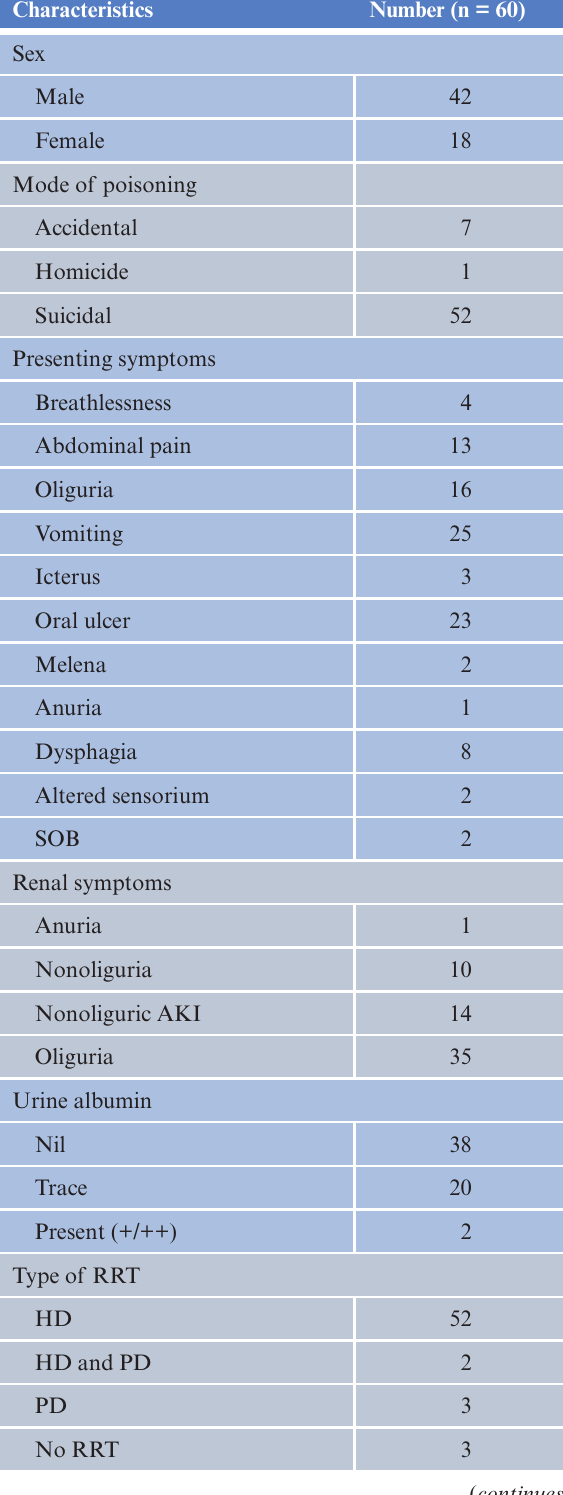
Table 1: Baseline characteristics for hospital